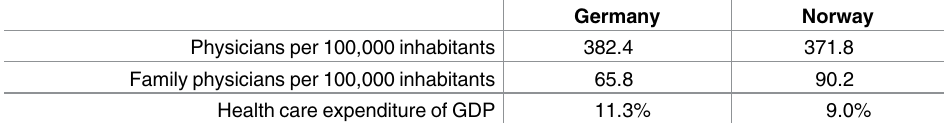
Table 1. Number of physicians and health care expenditure compared between Germany and Norway